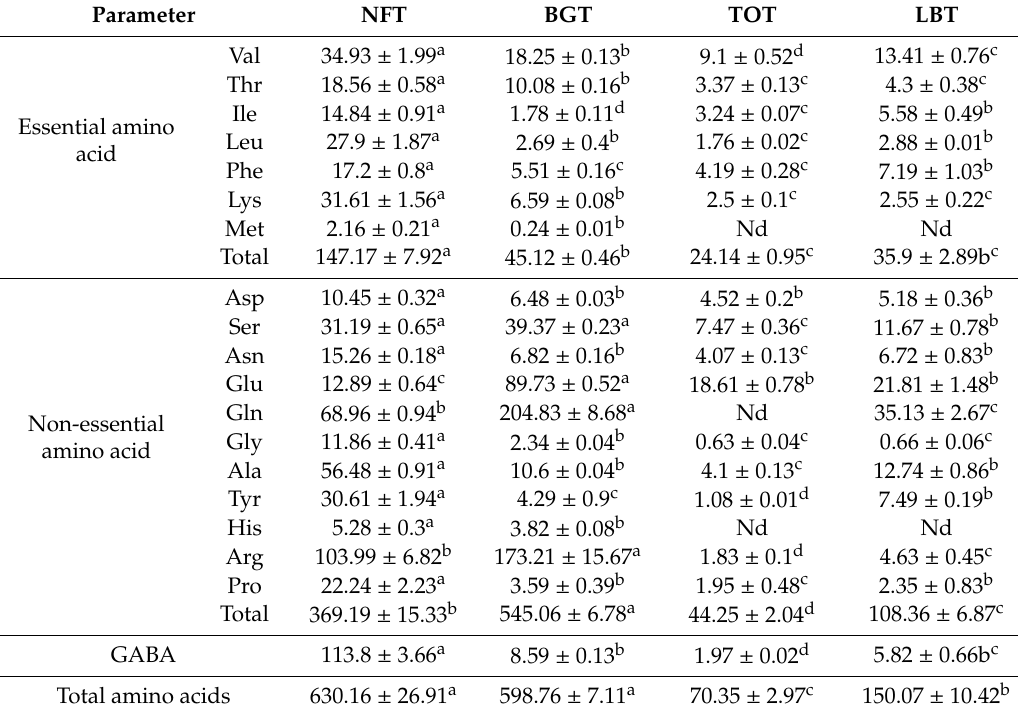
Table 5. Quantification of amino acid contents in di ff erent tea samples (mg / 100 g).